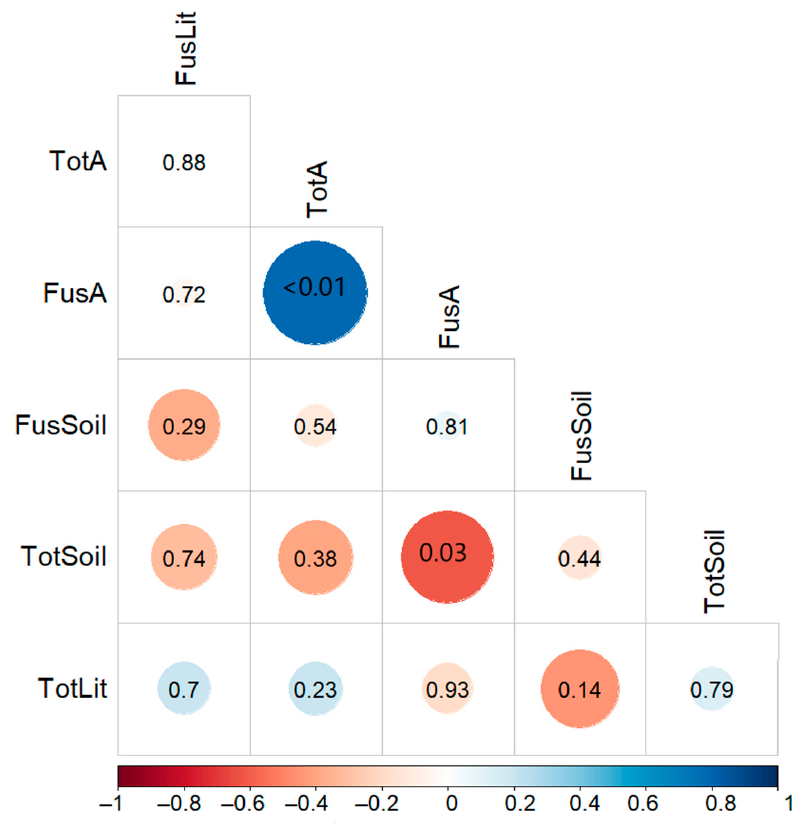
Figure 3. Correlation matrix with the Spearman correlation coefficients between the total fungal (Tot) and Fusarium (Fus) load on the body surface of arthropods (A), and abundance of Fusarium and total fungi in soil (Soil) and litter (Lit) samples, respectively. Darker colors and larger circles indicate stronger correlations. p -values are given for each correlation.